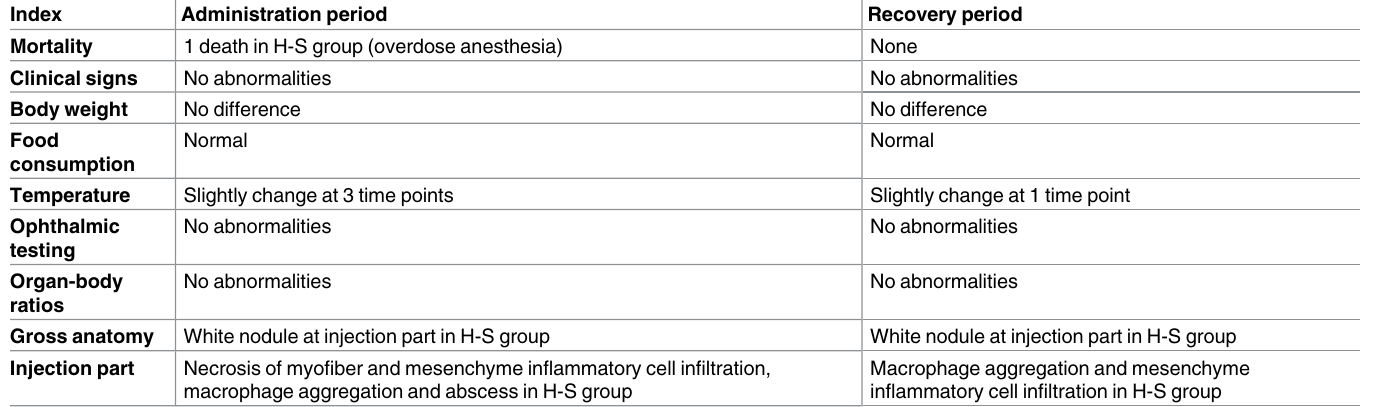
Table 1. Preliminary GLP pre-clinical long term toxicity tests in